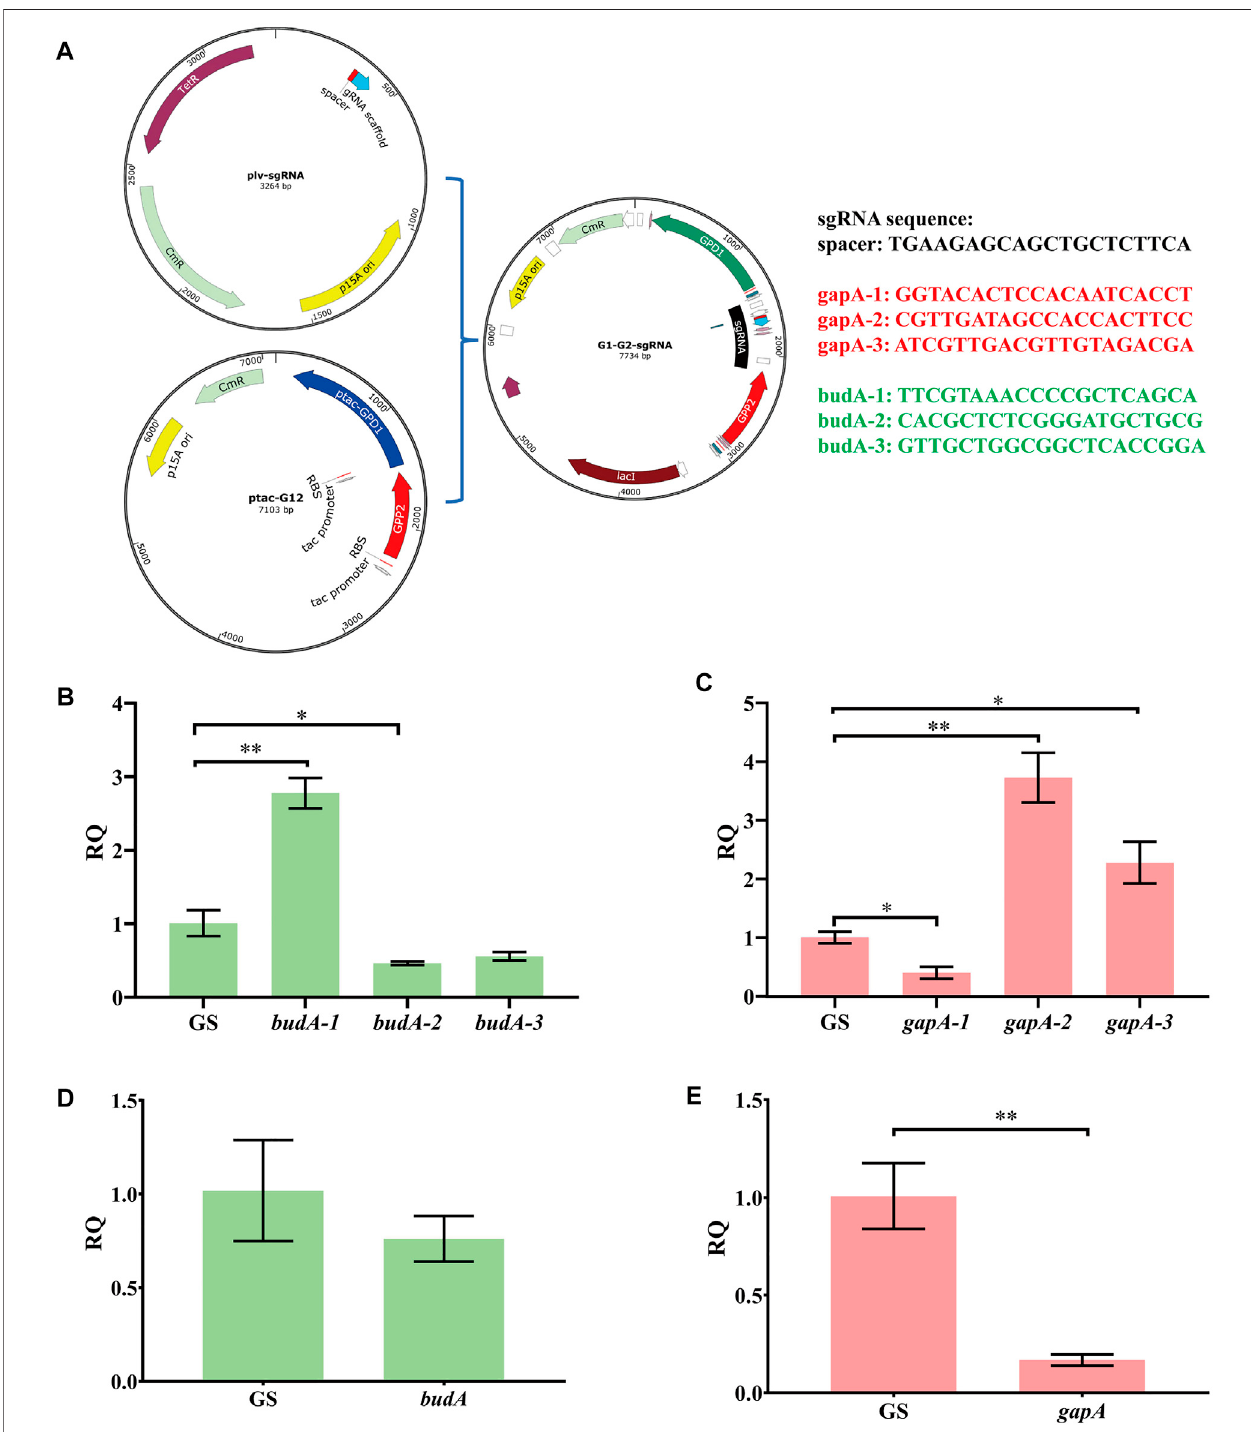
FIGURE 4 | Relative transcription quantity of K. pneumoniae with dCas9 integrated in genome and an engineered CRISPRi system. (A) Schematic diagram of linking sgRNA to plasmid ptac-G12 co-expressing gpd1 and gpp2 . (B) RT-qPCR analysis ofCRISPRi inhibition on different regions of the budA gene. budA -1, budA -2, and budA -3represent differentregionsof budA gene.GS,recombinant K.pneumoniae harboringthenon-targetingCRISPRisystem. (C) RT-qPCRanalysisofCRISPRi inhibition on different regions of gapA gene. gapA -1, gapA -2, and gapA -3 represent different regions of the budA gene. (D) RT-qPCR analysis of transcription inhibition on the budA gene by the CRISPRi system carrying the sgRNAs for both budA and gapA . (E) RT-qPCR analysis of transcription inhibition on the gapA gene by the CRISPRi system carrying the sgRNAs for both budA and gapA . gapA -1, gapA -2, and gapA -3 denote different regions of the gapA gene. RQ, relative quantity of transcription. * p < 0.05 and ** p <